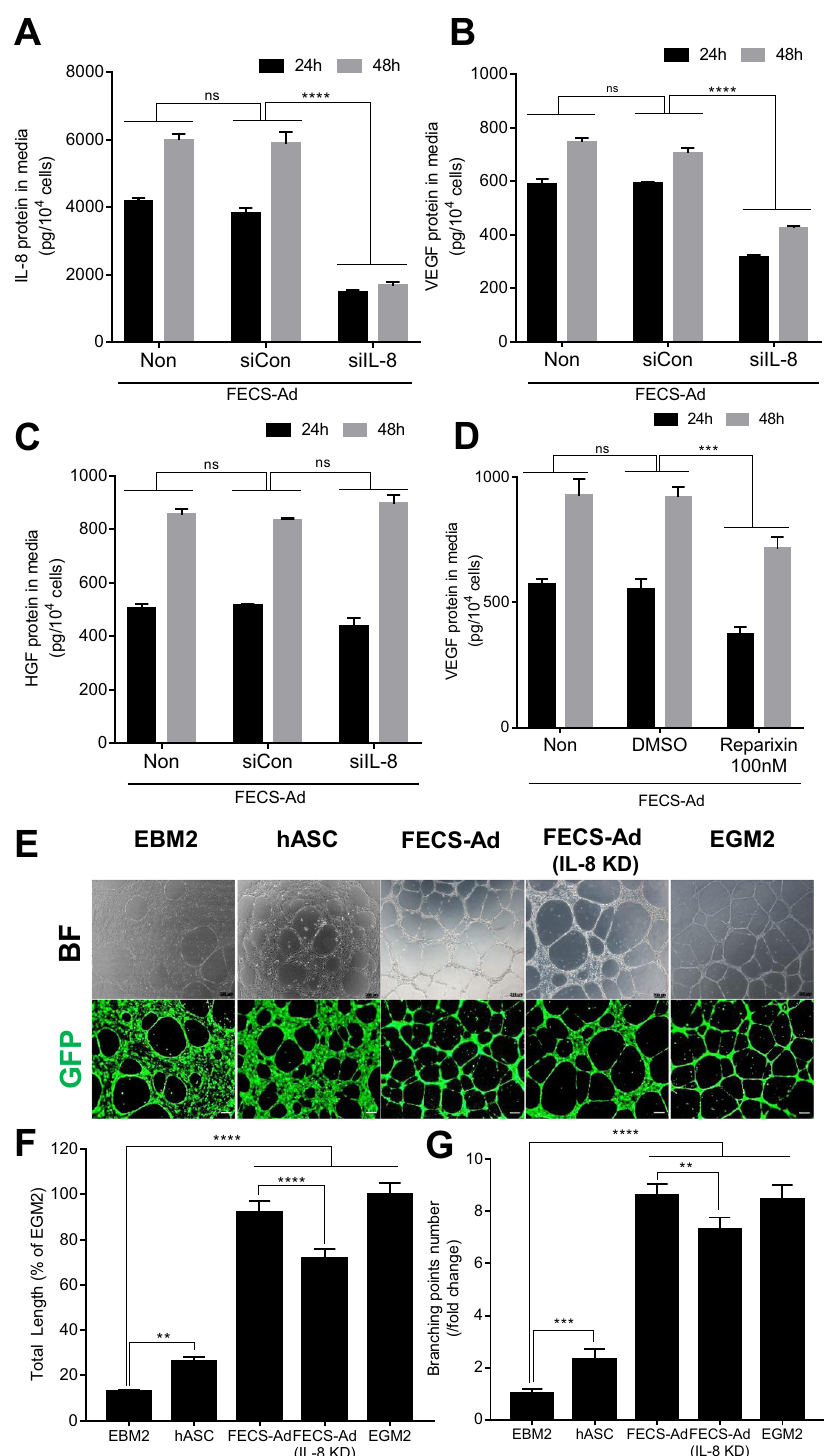
Fig. 6 Effect of IL-8 from FECS-Ad on the angiogenic potential in vitro. A – D hASCs were treated with FGFR1 siRNA or reparixin, an IL-8 receptor inhibitor, and cultured on MBP-FGF2 surface to form FECS-Ad. Conditioned medium from FECS-Ad were prepared and analyzed by ELISA. A Knockdown ef fi ciency of IL-8 protein in FECS-Ad. ns not signi fi cant, **** p < 0.0001 (two-way ANOVA), n = 3 per group. Effect of IL-8 knockdown on B VEGF and C HGF protein. ns not signi fi cant, **** p < 0.0001 (two-way ANOVA), n = 3 per group. D Effect of reparixin on VEGF protein. ns not signi fi cant, *** p < 0.001 (two-way ANOVA), n = 3 per group. E – G GFP-HUVECs plated on matrigel were co-cultured with hASCs, FECS-Ad, or IL-8 silenced FECS-Ad in transwell plate for 16 h. E Effect of hASC co-culture on the tube formation of HUVECs. F Effect on the total tube length of HUVECs. ** p < 0.01, *** p < 0.001, **** p < 0.0001 (one-way ANOVA), n = 5 per group. G Effect on the number of branching points of HUVECs. ** p < 0.01, *** p < 0.001, **** p < 0.0001 (one-way ANOVA), n = 5 per group. All data are presented as mean ±